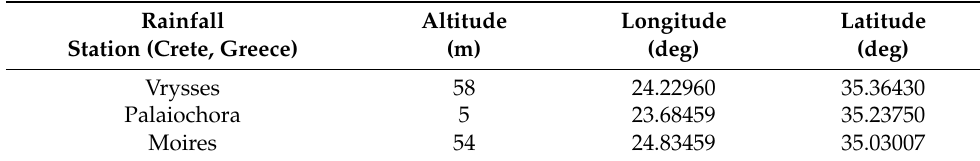
Table 1. Rainfall stations